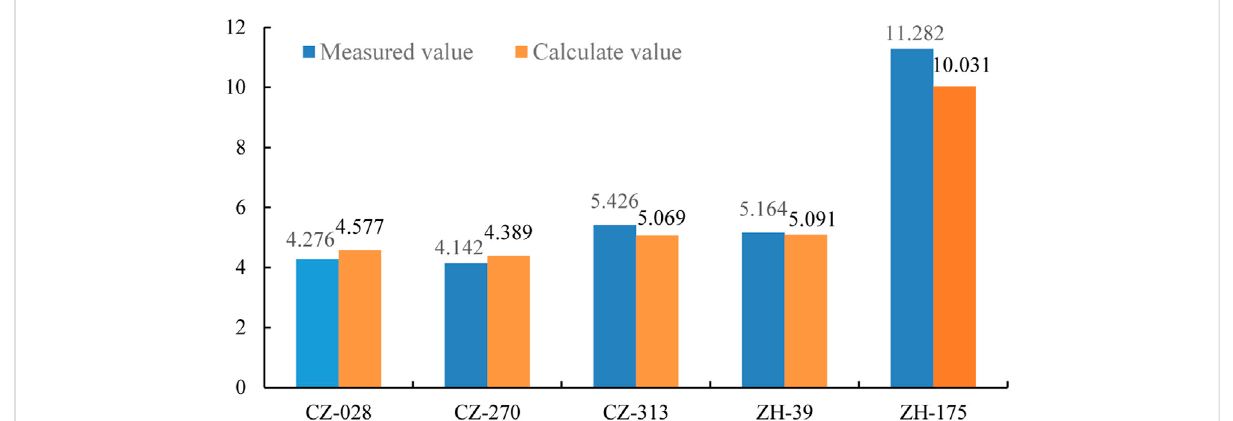
FIGURE 8 Comparison of measured and predicted (the single-phase gas fl ow